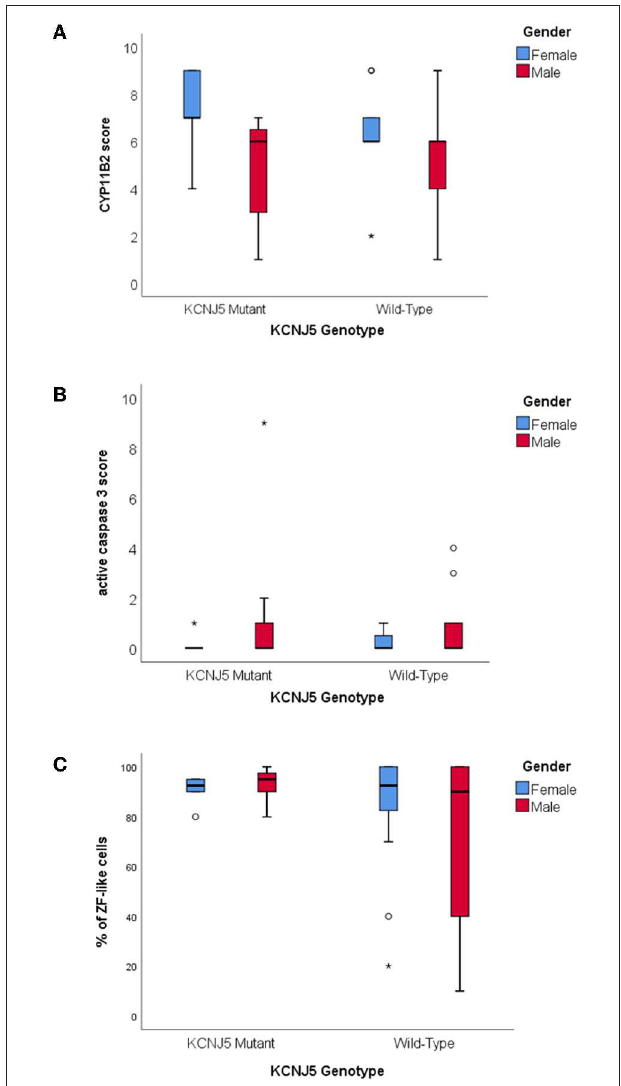
FIGURE 3 | Histological characteristics of KCNJ5 mutant APAs. (A) CYP11B2 protein expression, (B) active caspase 3 protein expression, and (C) percentage of ZF-like cells (i.e., cells with high cytoplasm: nucleus ratio), in KCNJ5 mutant APAs grouped by